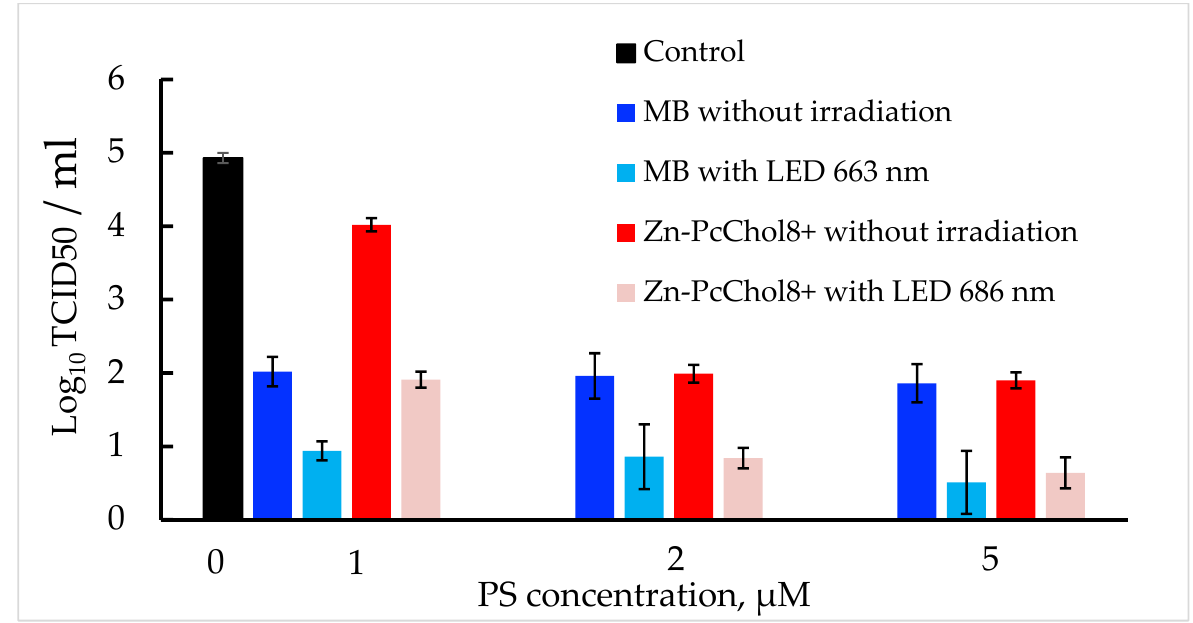
Figure 3. BCoV titers without PSs and irradiation (control), preincubated at 10 min, with different concentrations of PSs without further irradiation, or irradiated with LED 663 nm for MB, or 686 nm for Zn-PcChol 8+ photoactivation, in a dose of 4.0 J/cm 2